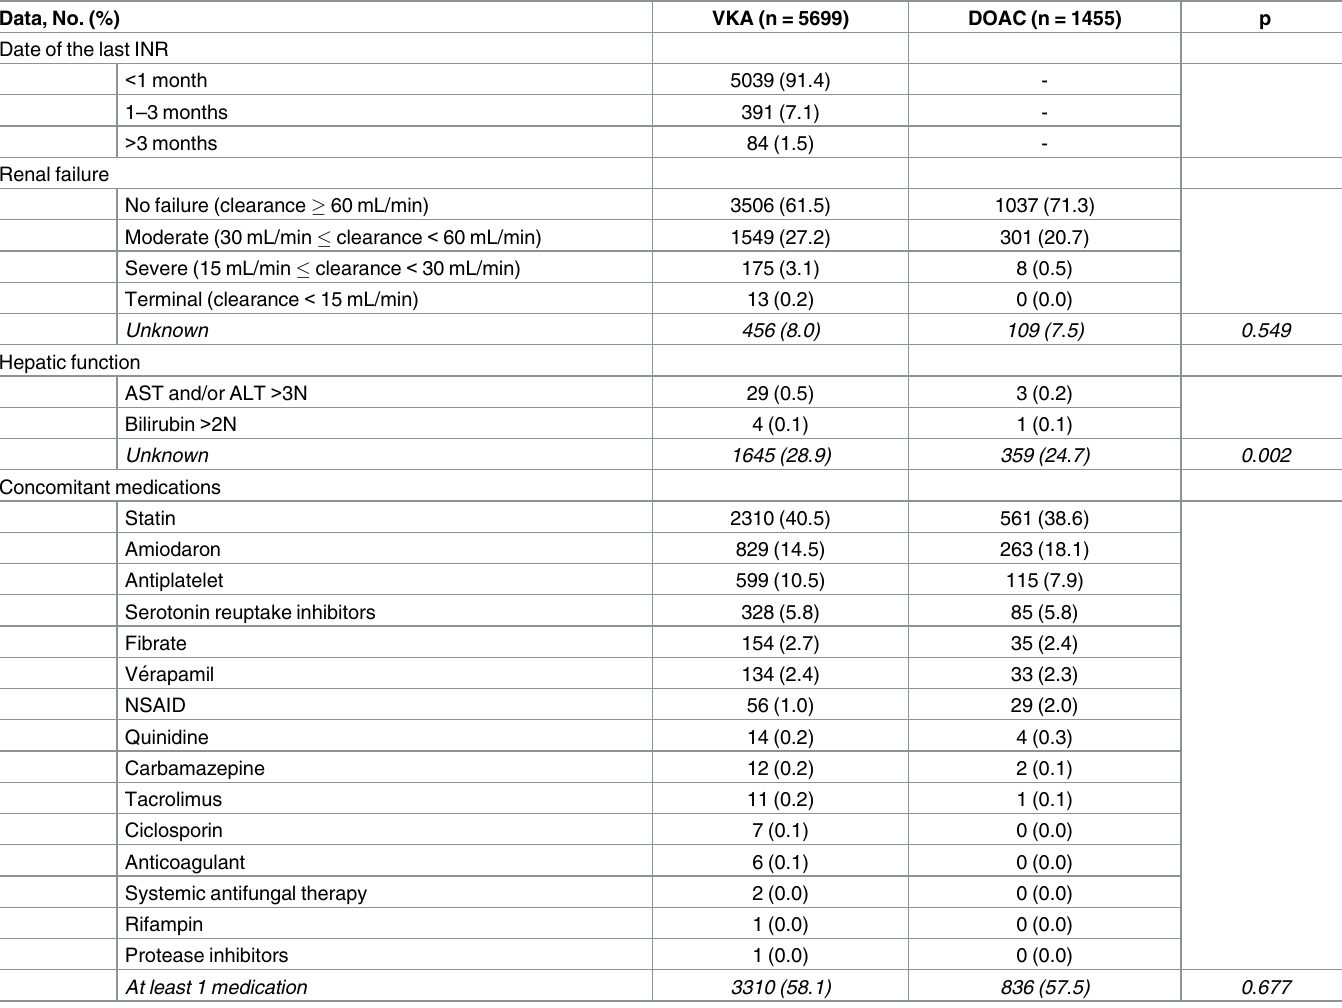
Table 2. Safety data in patients’ records.